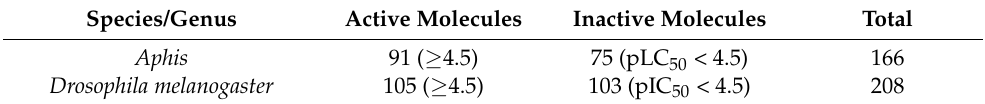
Table 13. Set of molecules from the ChEMBL databases for each species or genus selected in the study.